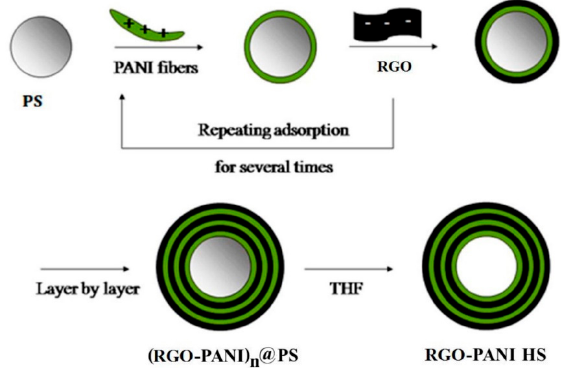
Figure 15. The illustration of the fabrication procedure of graphene—PANI hollow spheres (rGO-PANI HS) [76].